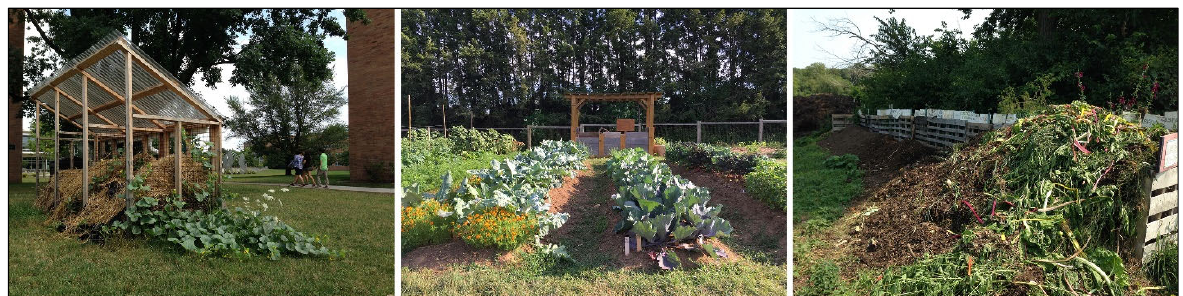
Figure 8. Compost Areas in Different Settings: Central Campus (Left), Campus Edge (Center), and Off-Campus (Right)